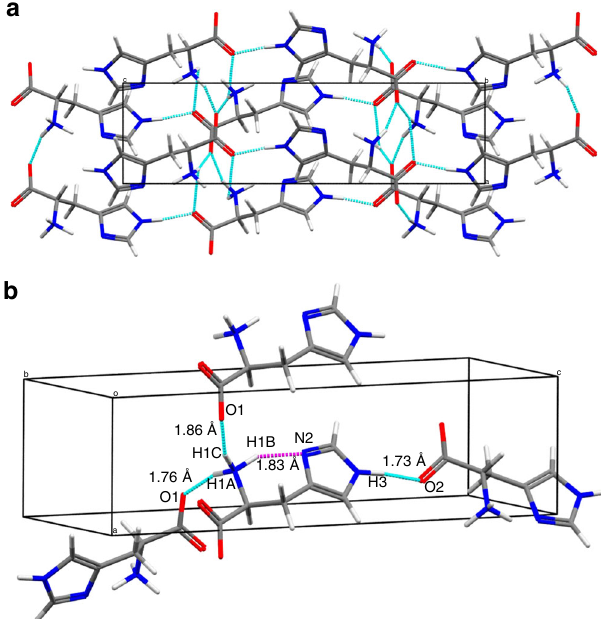
Fig. 3 Hydrogen-bonding network in LH1. a Molecular packing structure of LH1 in the ac plane. b Extraction of hydrogen bonds showing the corresponding internuclear distances for each bond. The sky-blue and magenta broken lines indicate inter- and intramolecular hydrogen bonds, respectively. The structures were optimized via GIPAW